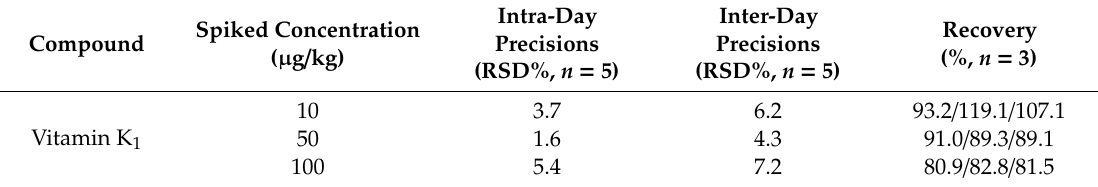
Table 2. Precision and accuracy of the